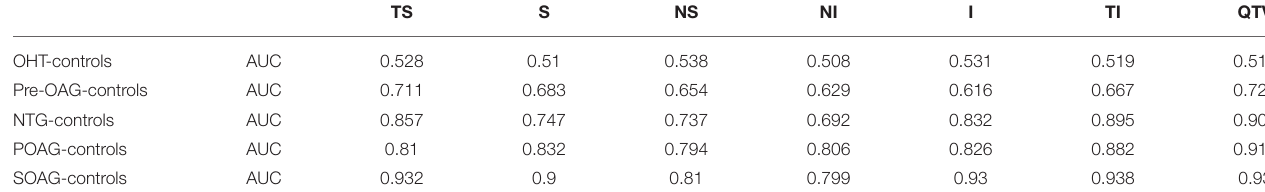
TABLE 6 | AUC of ROC analysis of qualitative RGCL thickness score for each subgroup (OHT, pre-OAG, NTG, POAG, SOAG vs. controls, respectively): total (QTV, qualitative total value) and sectorial (TS, temporal superior; S, superior; NS, nasal superior; NI, nasal inferior; I, inferior; TI, temporal inferior).